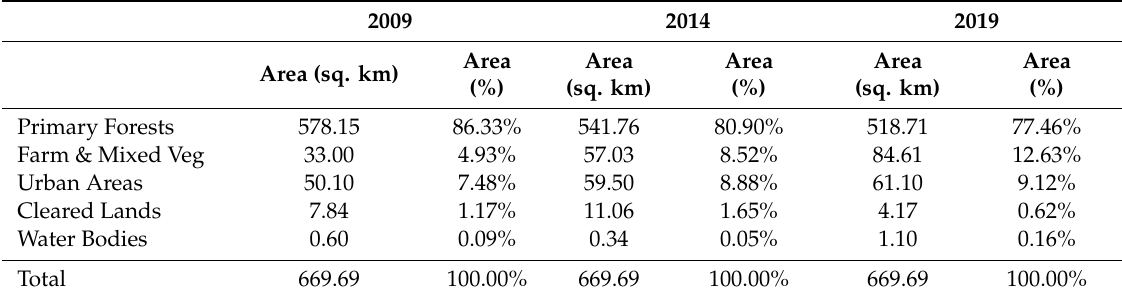
Figure 5. Land cover classification of Cameron Highlands in 2014. Table 4. Land cover area change in Cameron Highlands.